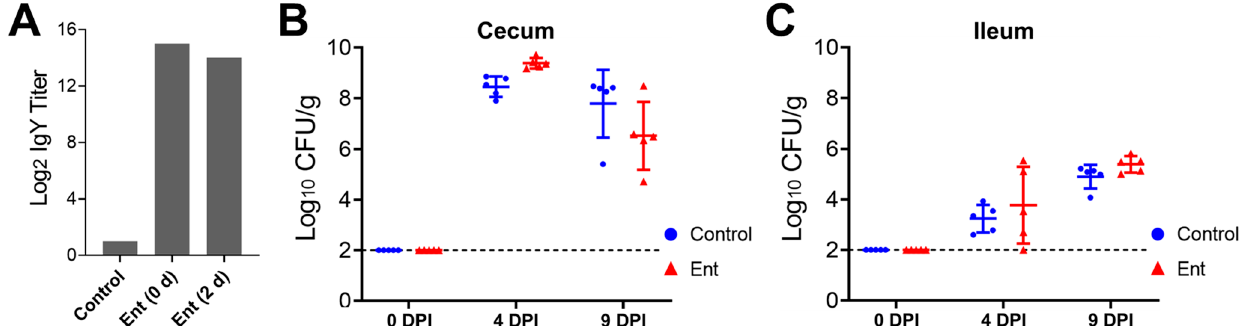
Figure 1. C. jejuni colonization levels in the chicken intestine upon anti-Ent egg yolk powder treatment. ( A ) Ent conjugate vaccine-specific IgY titer in chicken feed. ELISA analysis was performed to determine the titer of the Ent conjugate-specific egg yolk IgY in the control feed (regular feed) or the feed supplemented with 2% ( w / w ) hyperimmune egg yolk powder (designated as “Ent”). With respect to the feed supplemented with the egg yolk powder, both freshly prepared feed (0 d) and the feed with 2 days of exposure in the chicken house (2 d) were subjected to ELISA analysis. Each bar represents duplicate measurements of the sample. ( B ) Colonization of C. jejuni NCTC 11168 in the cecum. ( C ) Colonization of C. jejuni NCTC 11168 in the ileum. The intestinal samples were collected from 0, 4, and 9 DPI for C. jejuni enumeration. Each dot represents log 10 -transformed CFU per gram of intestinal contents in an individual chicken. The bar represents mean ± SD within each treatment group. The dashed line indicates the detection limit.